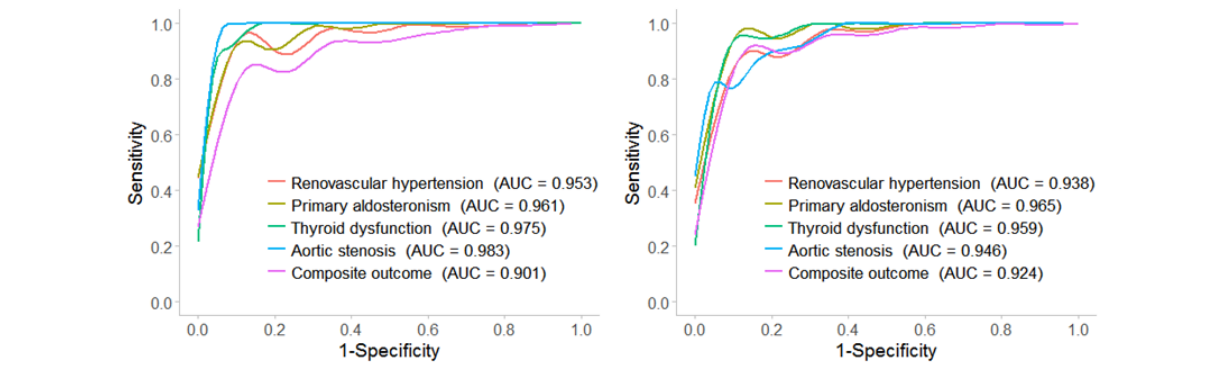
Figure 3. ROC curves for prediction models in both data sets. (A) ROC curves for prediction models in the test data set of the modeling data set. (B) ROC curves for prediction models in the validation data set. AUC: area under ROC; ROC: receiver-operating characteristic curve.